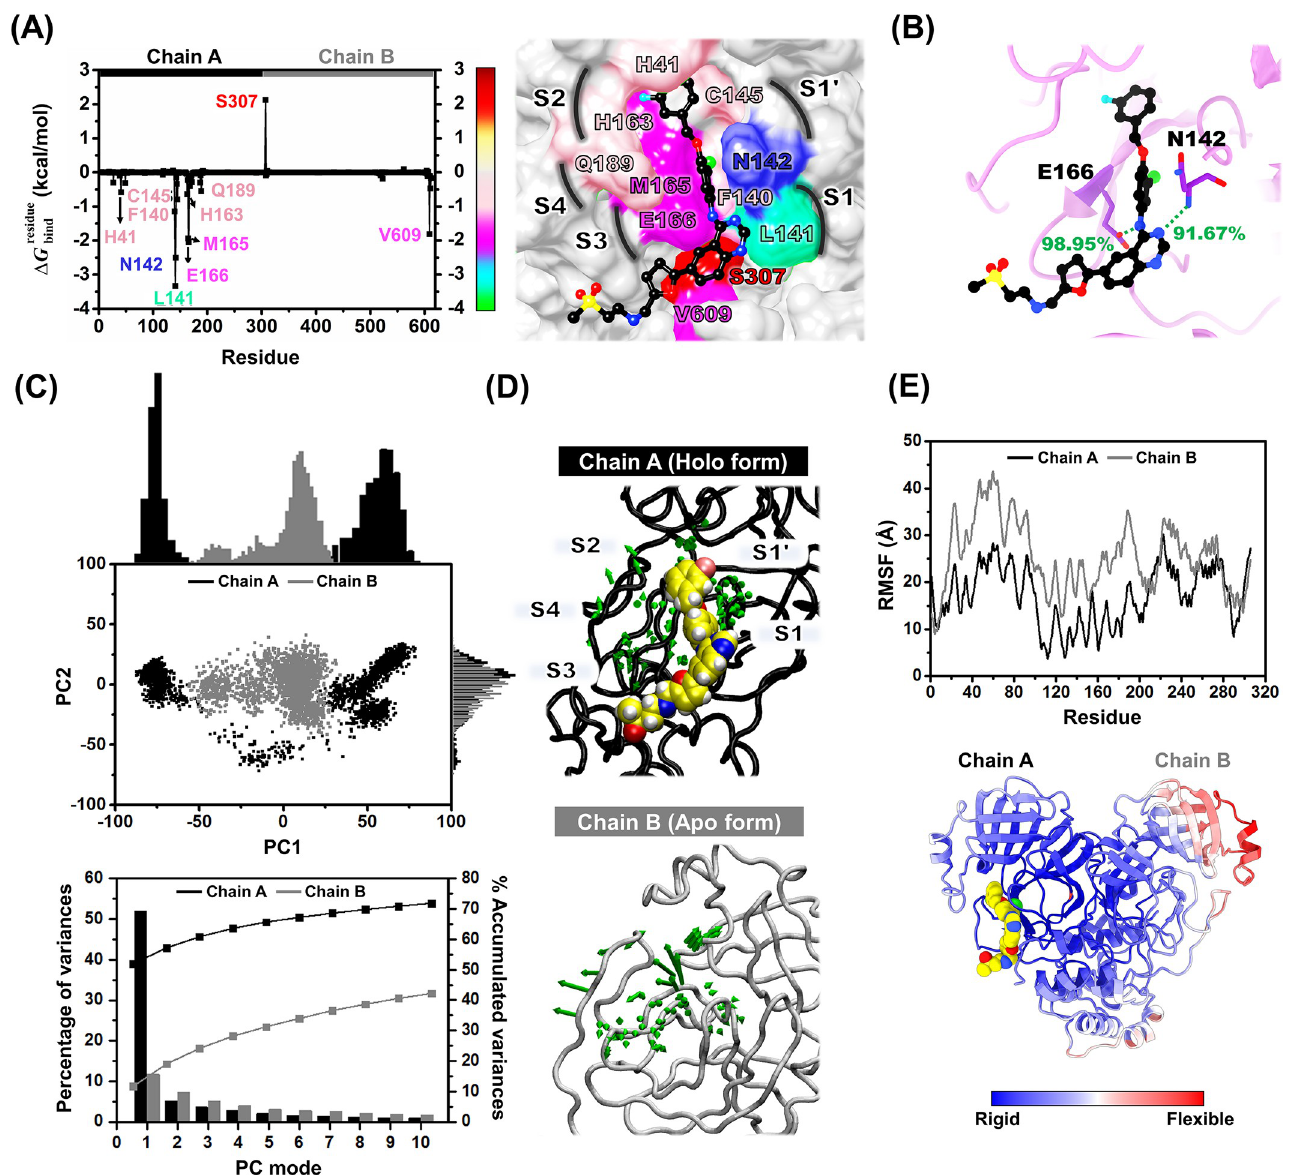
Fig 7. Key binding residues and protein motions of SARS-CoV-2 3CL pro /lapatinib complex. (A) Binding free energy contribution per residue ( D G residue lapatinib binding derived from the last 100 ns, colored from dark red to green according to the highest to lowest free energies. The residues with D G residue kcal/mol and � 0.5 kcal/mol are labeled. The key residues are colored according to their D G residue snapshot. Noted that the quinazoline scaffold of lapatinib highly interacted with L141 at the S1 site ( D G residue bond occupation are shown in (B). (C) 2D projection of MD trajectories on the first two PC modes and PCA scree plot, (D) PC1 porcupine plot of the holo and apo forms, where the arrowhead and length represent the direction and amplitude of motion, respectively, and (E) RMSF plot of 3CL pro in each